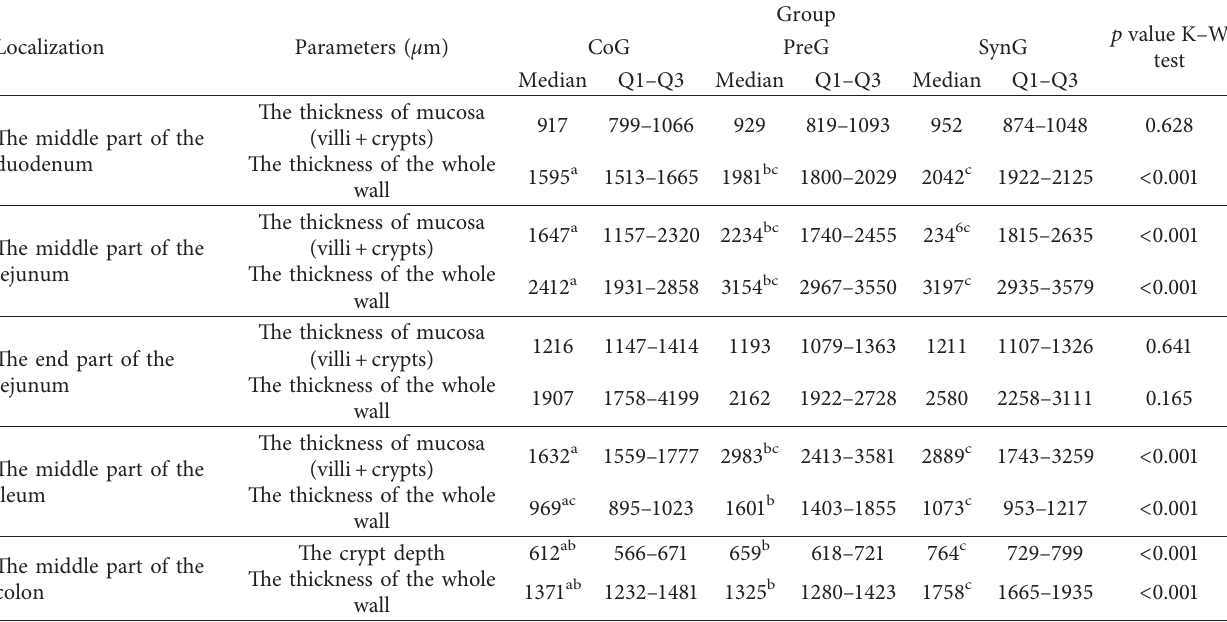
Table 4: Results of histological examination of intestines.